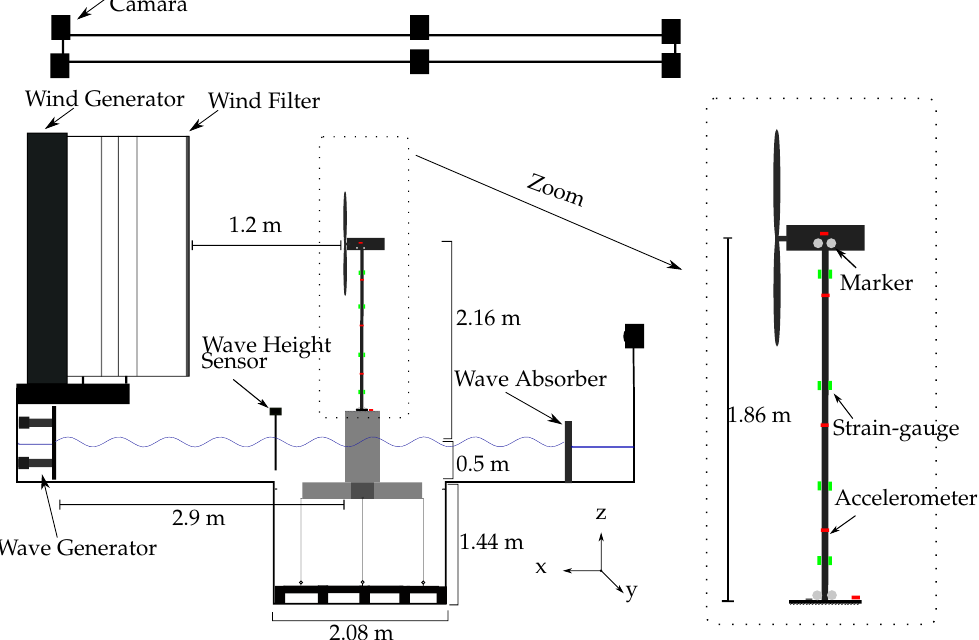
Figure 3. Overview of laboratory facilities and experimental